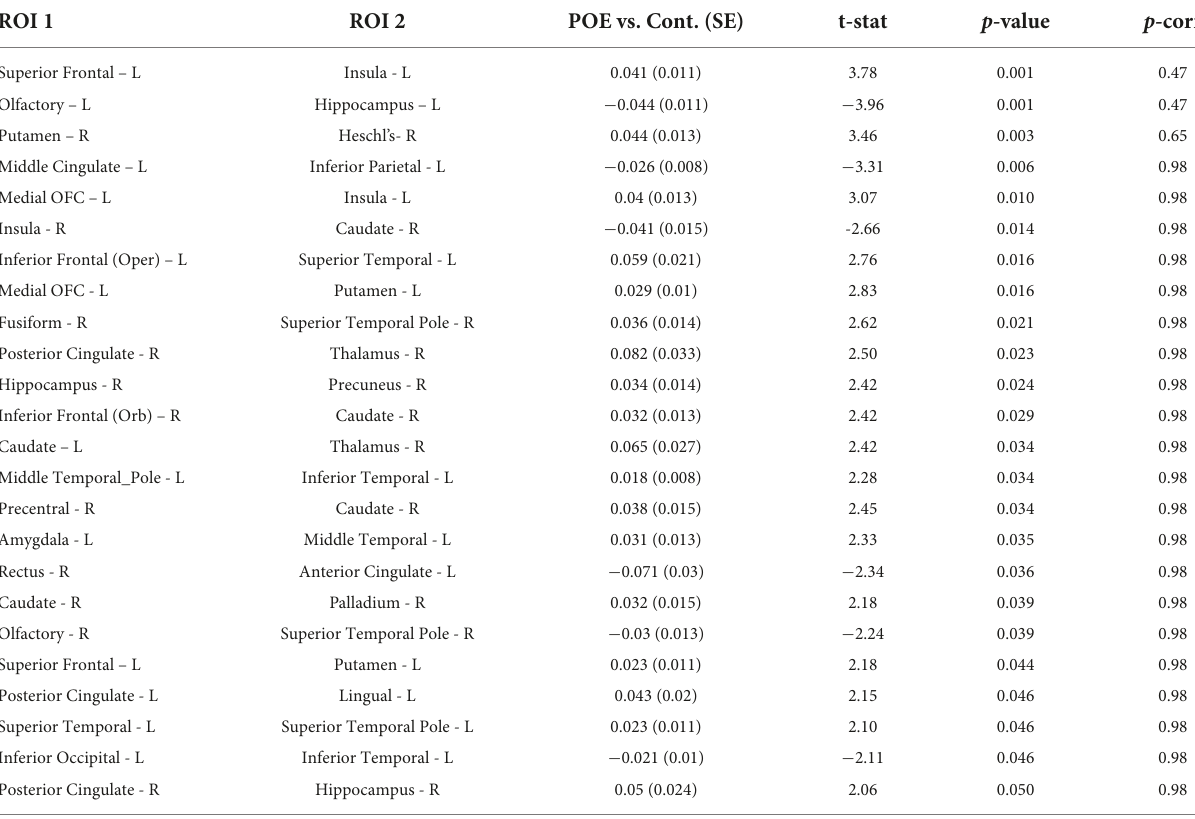
TABLE 3 Connectivity values between POE and opioid naïve infants based on fractional anisotropy (FA). ROI 1 ROI 2 POE vs. Cont. (SE)